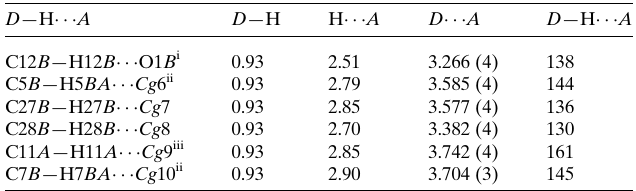
Table 1 Hydrogen-bond geometry (A˚ , (cid:4) ) for II